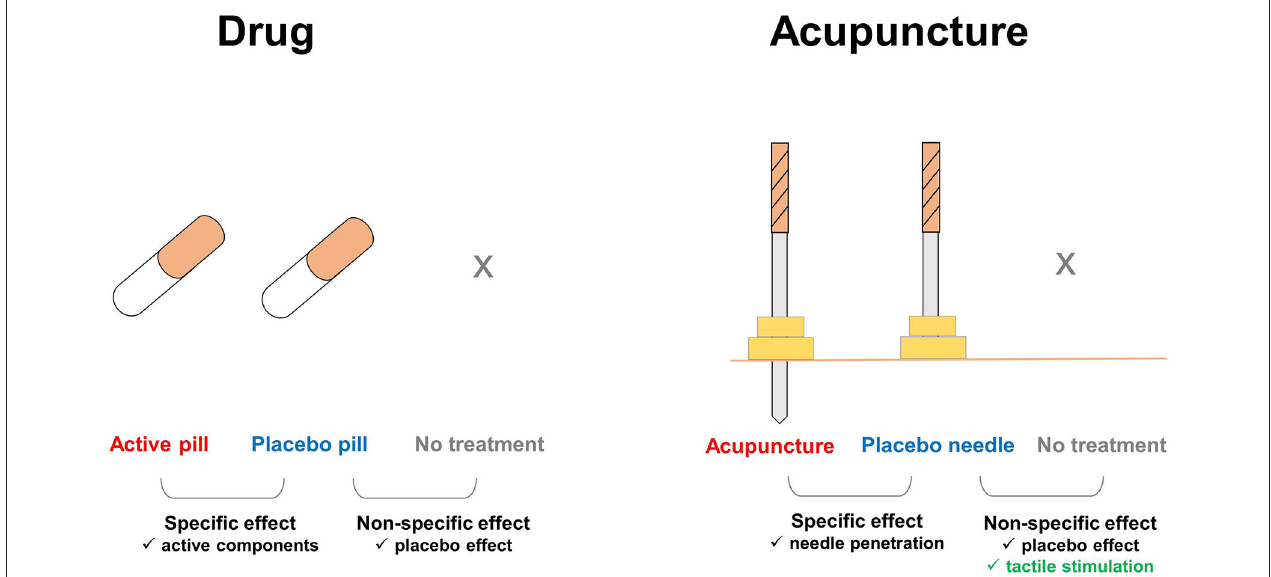
FIGURE 1 | Additional components involved in the effects of placebo needles. In pharmaceutical trials, the nonspecific effects of treatments can be ruled out by comparing the placebo pill group with an untreated group, e.g., on a waiting list. In acupuncture trials, tactile stimulation is an additional factor that affects the placebo needle and untreated groups. Enhanced touch sensations, which are distinct during acupuncture treatment, but absent with placebo pills, remain substantial during placebo needle administration. Thus, placebo needles not only play a role as a cue for treatment expectations, but also evoke the somatosensory system and directly activate multiple brain